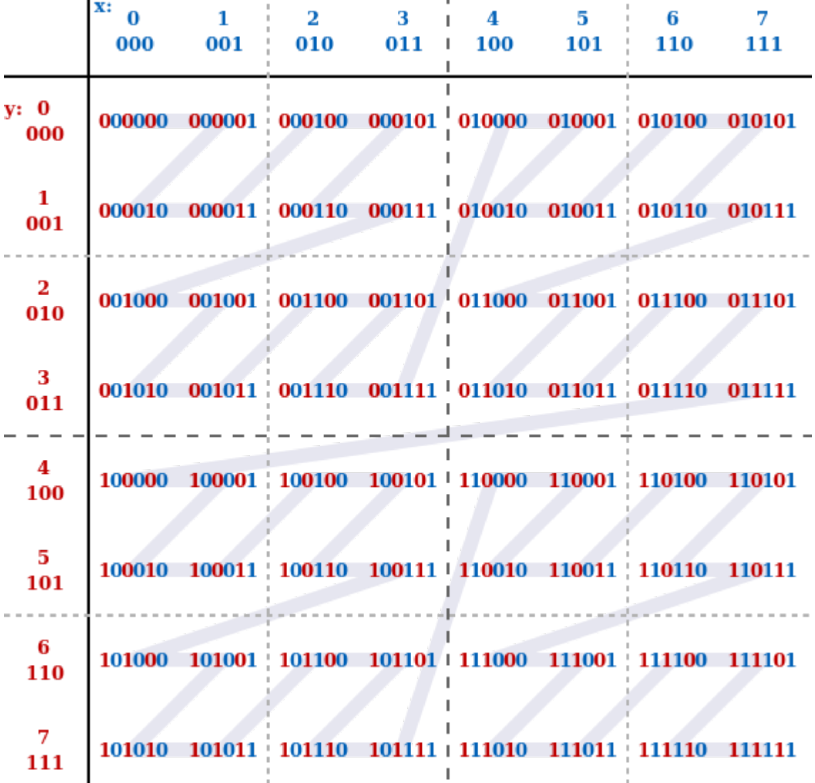
Figure 5. Using Z-order curve to interleave binary representations of integers between 0 and 7,